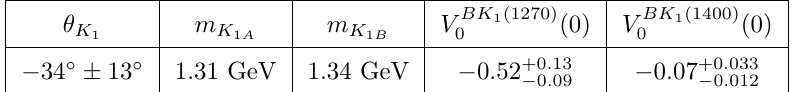
Table 13 . Values of the parameters in the vector form-factors (F.27), (F.28) from